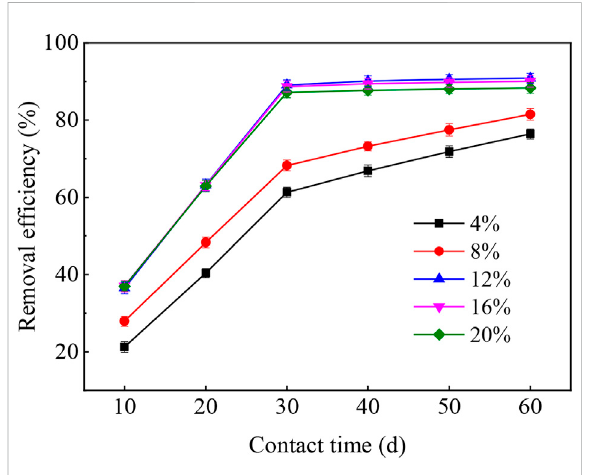
FIGURE 3 Phenanthrene removal from soil under different wheat straw biochar dosages. FIGURE 4